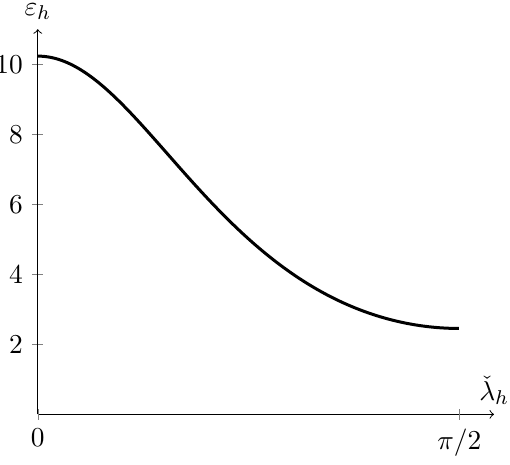
Figure 5: Dressed energy (4.32) of a hole as a function of its hole rapidity ˇ λ ∈ ( 0, π/ 2 ) for a chain at ∆ = h